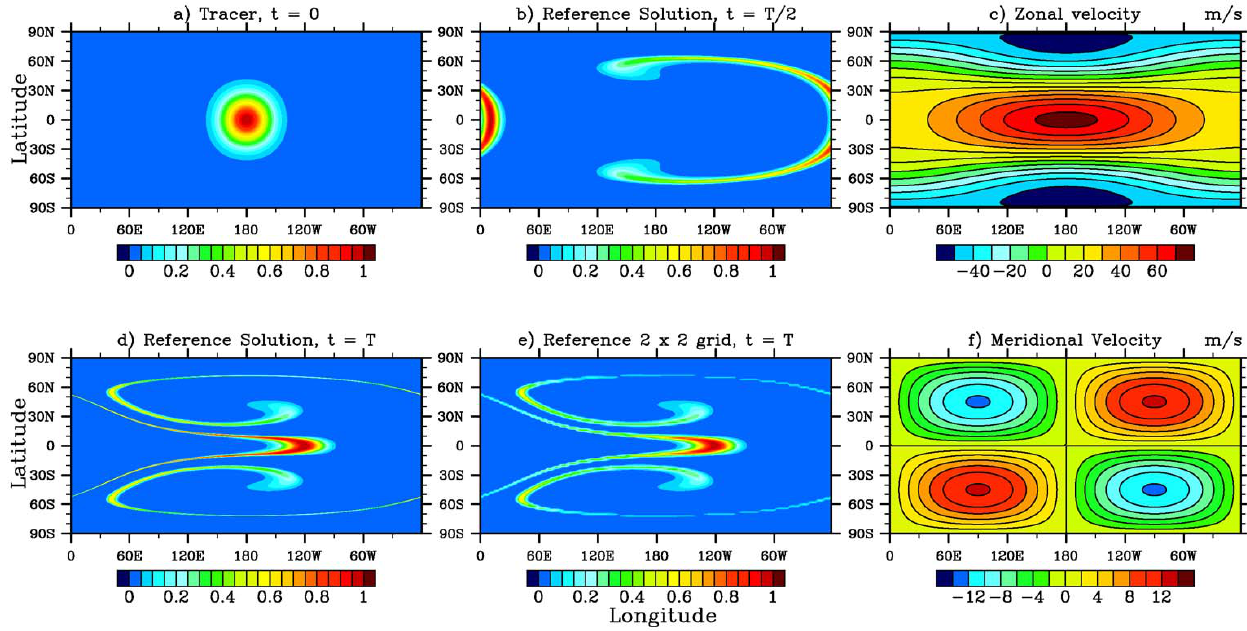
Fig. 1. Test 1, (a) initial tracer, (b) the CAM-FV reference solution at t = T/ 2 on the 0 . 125 ◦ × 0 . 125 ◦ grid, (c) the zonal velocity u , (d) the reference solution at t = T , (e) the reference solution averaged onto the coarse 2 ◦ × 2 ◦ resolution grid at time t = T , and (f) the meridional velocity, v